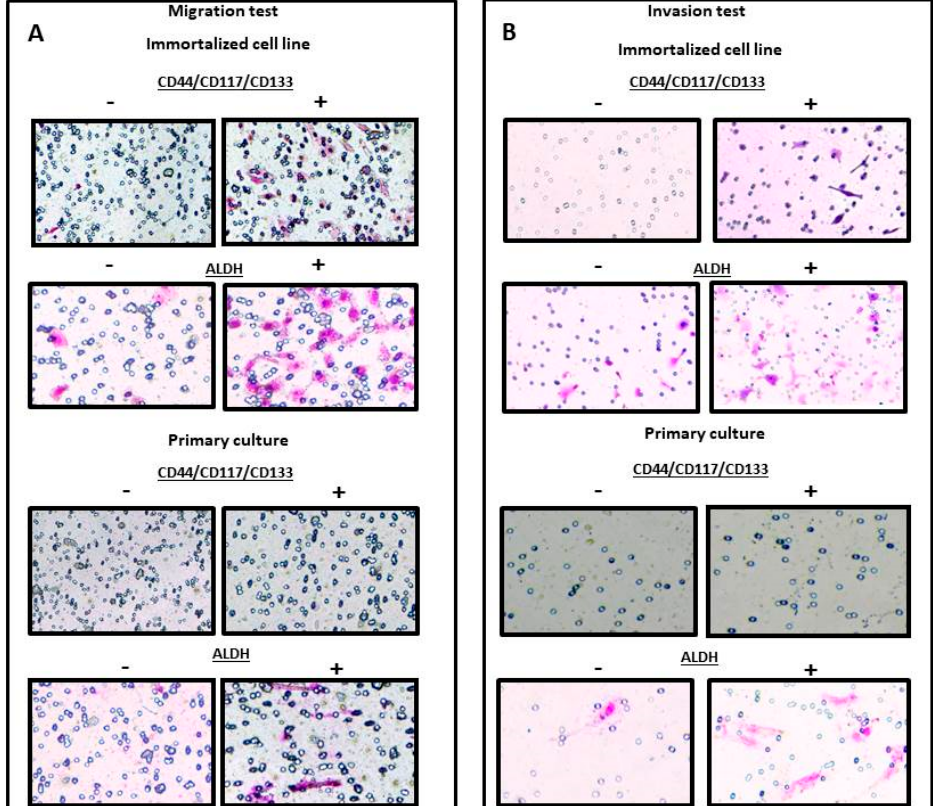
Figure 5. ( A ) Microphotography of the cells submitted to the migration assay (200× magnification). The isolated CD triple-marker positive and ALDH + cells showed a greater ability to migrate than the negative control group. In addition, the ALDH+ group showed a greater ability to migrate than the CDs+ group. ( A , B ) Microphotography of the cells subjected to the invasion assay (200× magnification). Cells labeled positively in general showed greater invasiveness than the negative control group, and a greater capacity for invasion was also observed in the ALDH+ group for the CD triple-marker positive cells.